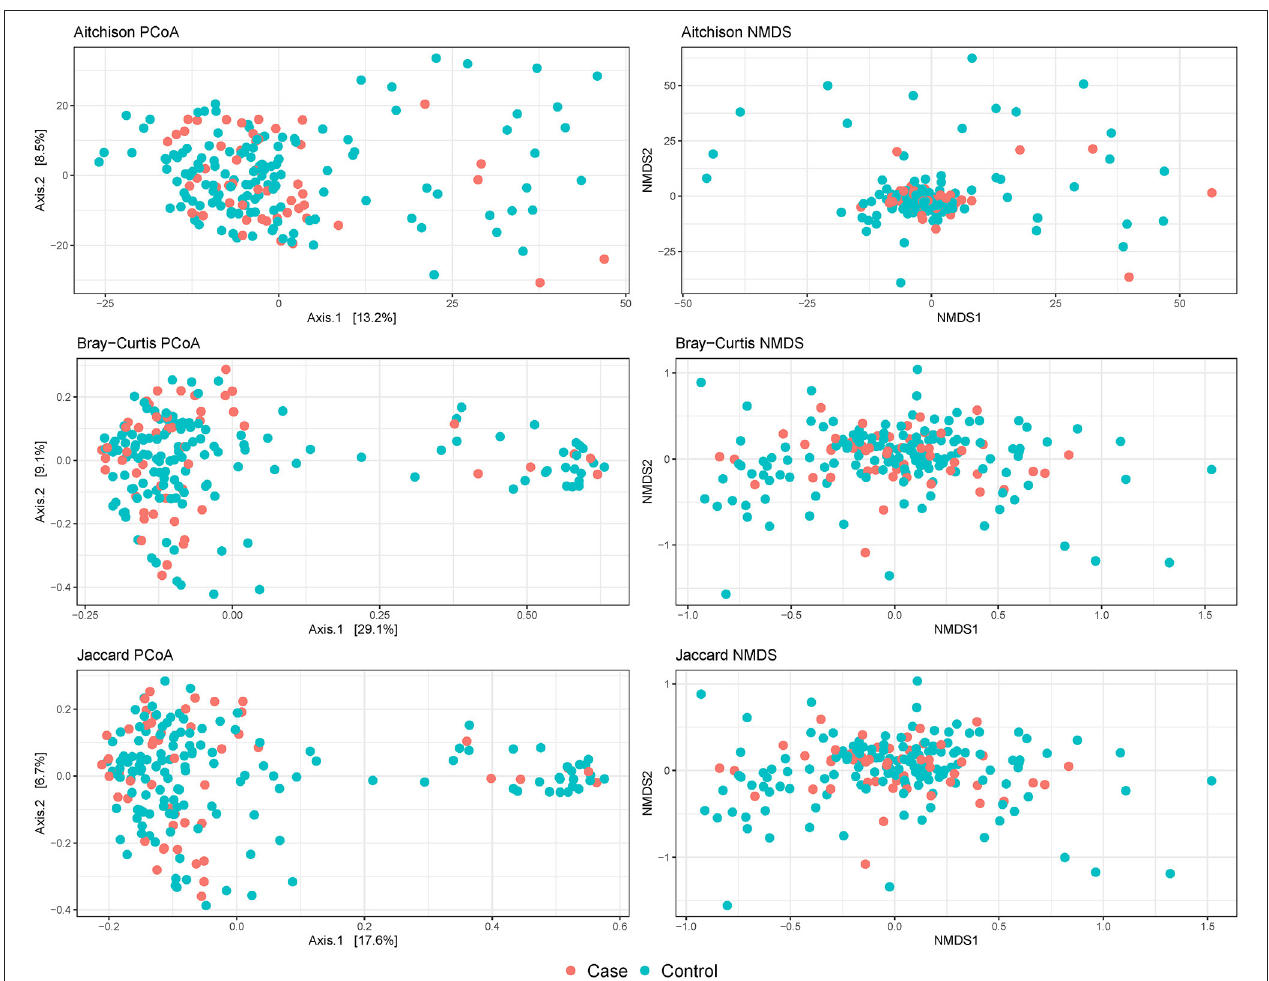
FIGURE 3 | Beta diversity plots of composite broiler litter samples. Samples are colored by the Campylobacter isolation status of the flock. Cases (orange) were defined as flocks with isolation of C. jejuni or C. coli in boot sock samples, and controls (tile) were defined as flocks without isolation of C. jejuni or C. coli in boot sock samples.